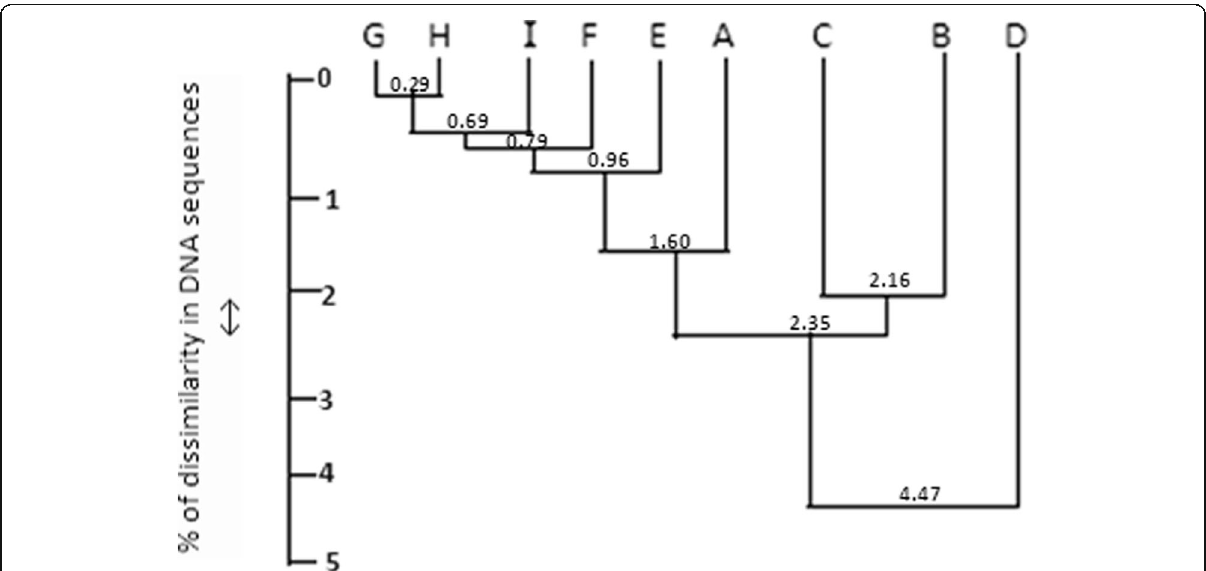
Fig. 11 Dendrogram (unrooted) showing % distance of the nine species of Chironomids under study. The scale on the left is a distance measure. A Chironomus javanus . B Chironomus xanthus . C Chironomus transvaalensis . D Chironomus dorsalis . E Chironomus riparius . F Chironomus maturas . G Chironomus maddeni ; H : Chironomus duplex ; and I : Chironomus